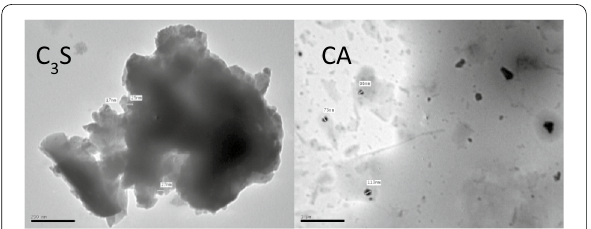
Fig. 2 Transmission electron photomicrographs (TEM) of tri-calcium silicate (nano-size C 3 S phase: 17–27 nm) and calcium aluminate (nano-size CA Phase: 73–113